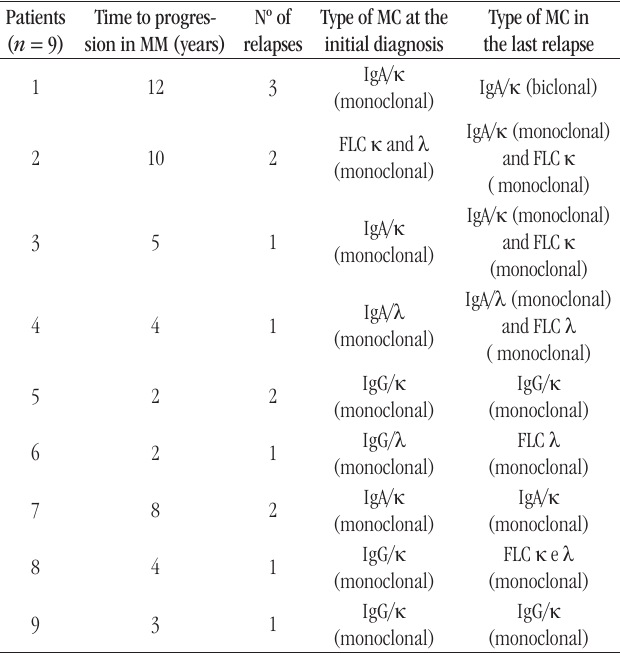
taBLE 5 − Behavior of monoclonal immunoglobulins at the initial diagnosis of MM and after detection of relapse by SIF